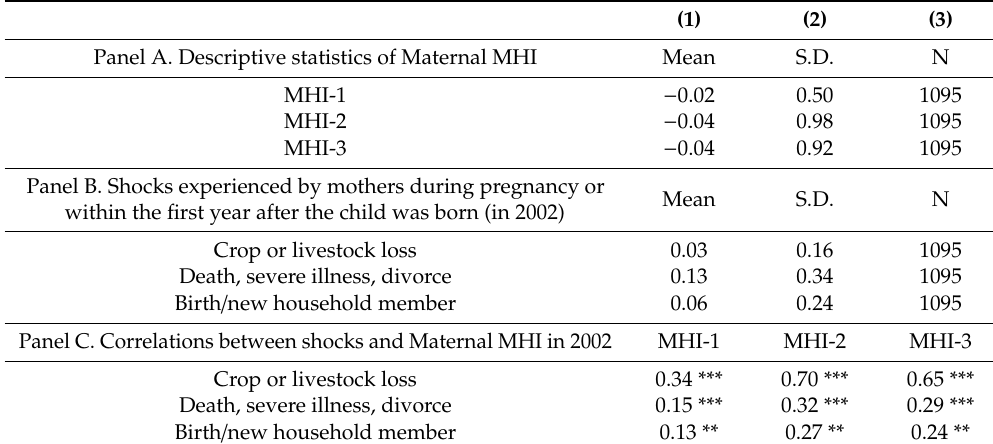
Table 2. Correlations between Shocks and Maternal Mental Health Indexes (MHI) in 2002. (1) (2) (3) Panel A. Descriptive statistics of Maternal MHI Mean S.D. N MHI-1 − 0.02